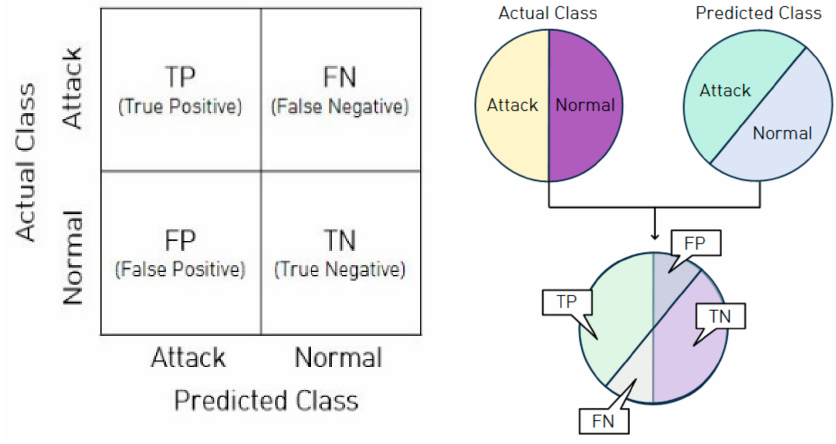
Figure 5. Relationships between TP, FP, FN, and TN.